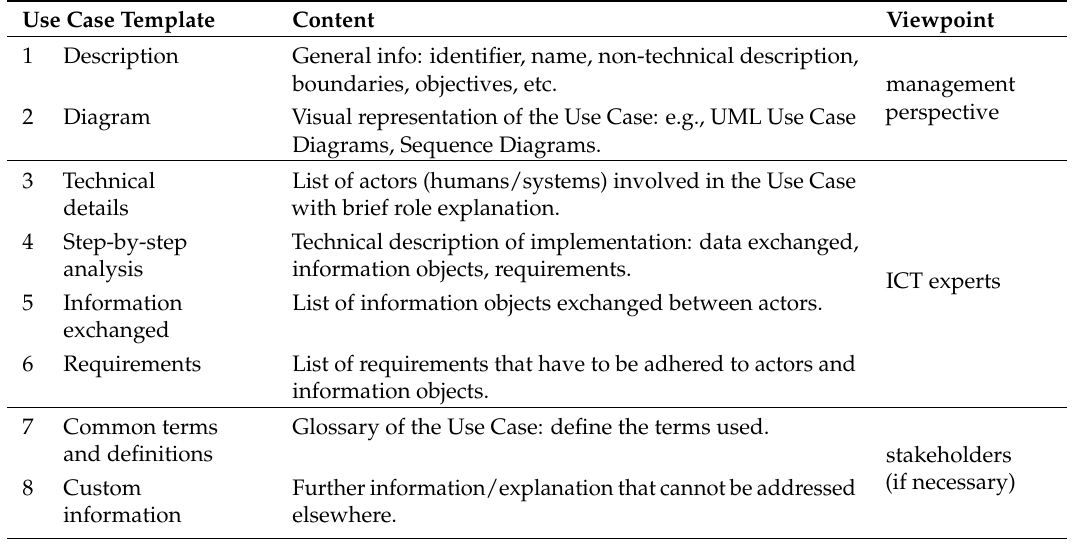
Table 1. The eight parts of the Use Case template—content and